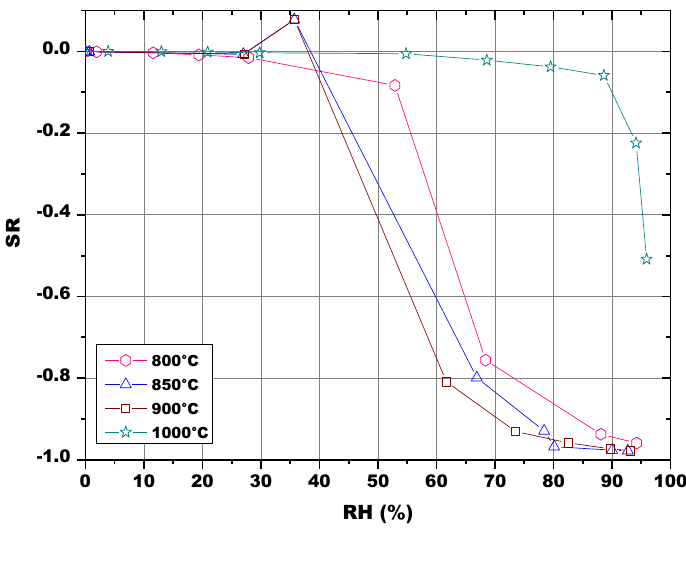
Figure 10. SR of the 5% SrO sensors (pellets) fired at different temperatures in function of RH at 23.6 °C ± 0.1